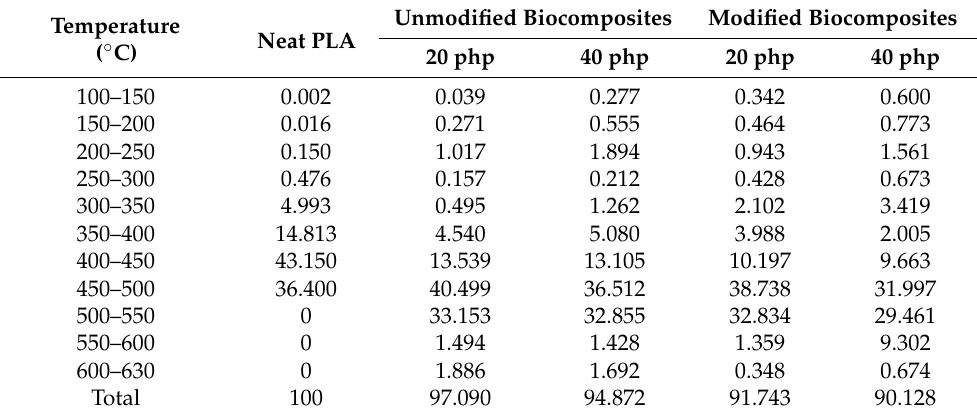
Figure 7. Effect of chitosan content and chemical modification on thermogravimetric properties of PLA/chitosan biocomposites. ( A ) weight loss versus temperature curves, ( B ) derivative thermo- gravimetry (DTG) curves. Table 3. Weight loss percentage of unmodified and modified PLA biocomposites containing chitosan fiber at different